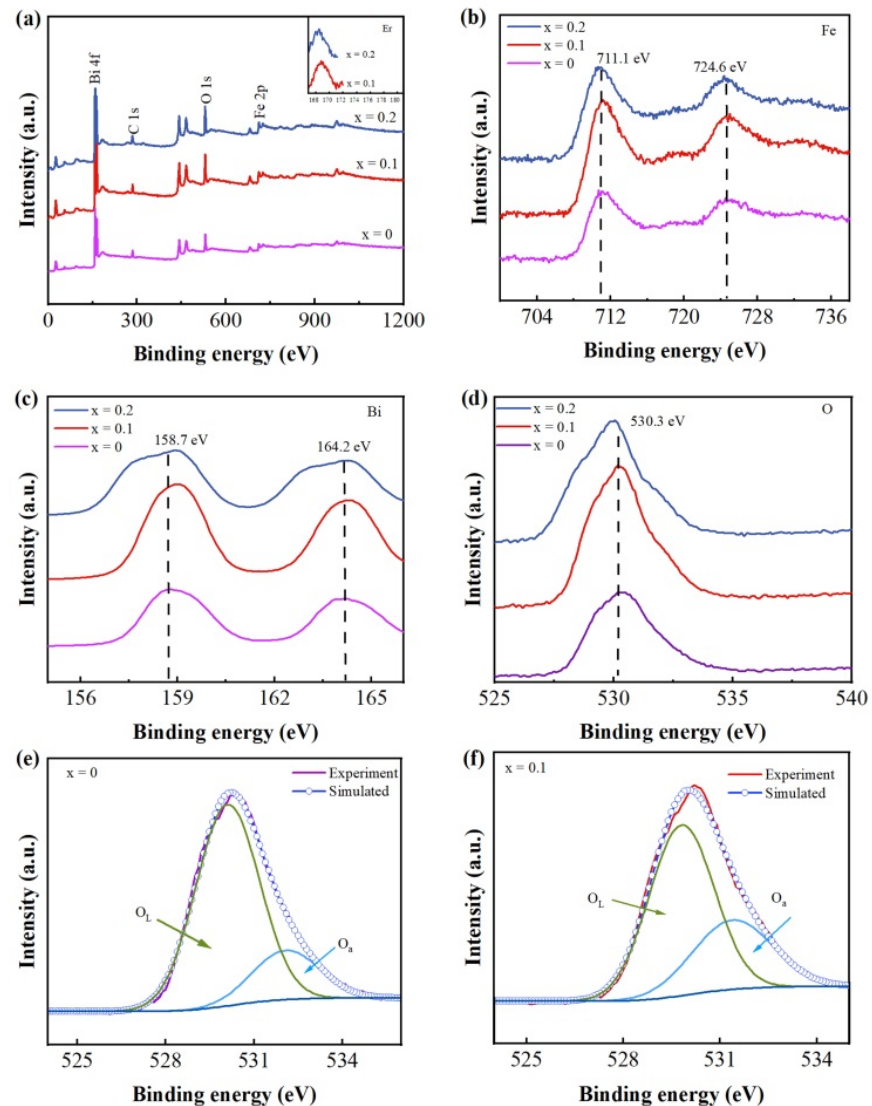
Figure 4 . XPS spectra of ( a ) Bi 1 − x Er x FeO 3 nanoparticles, ( b ) Fe 2p, ( c ) Bi 4f and ( d ) O 1s. The fitted curves of O 1s for ( e ) x = 0, ( f ) x = 0.1.